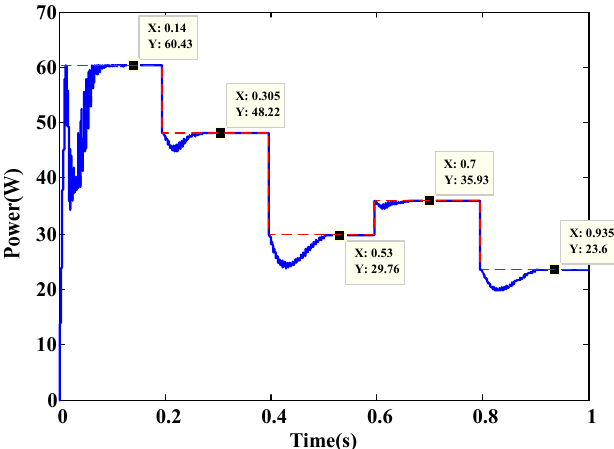
Figure 8. Simulation results using P-V slope and changes of slope as the